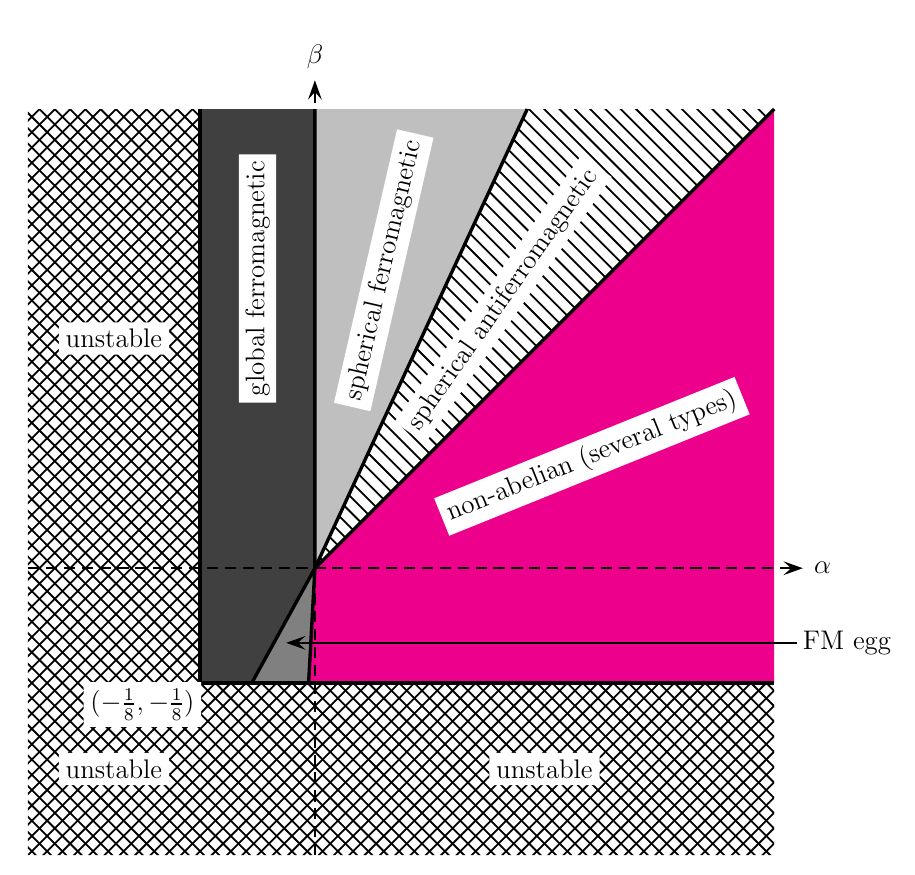
Figure 8: Orientation phase diagram of 3D quasi-instanton matter, regardless of lattice